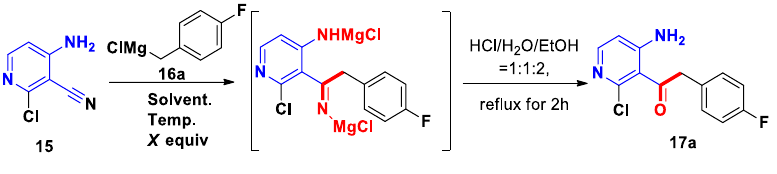
Table 1. Optimization of the reaction conditions a,b for the synthesis of